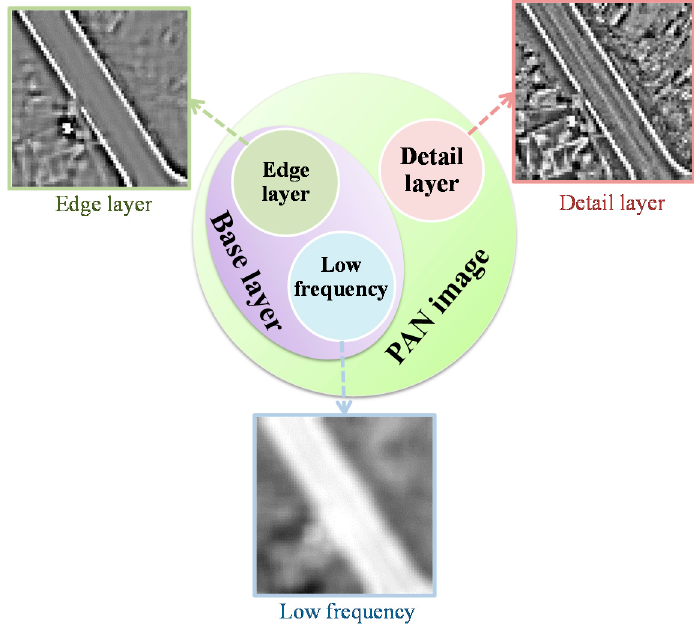
Figure 2. Schematic diagram of the three-layer decomposition.